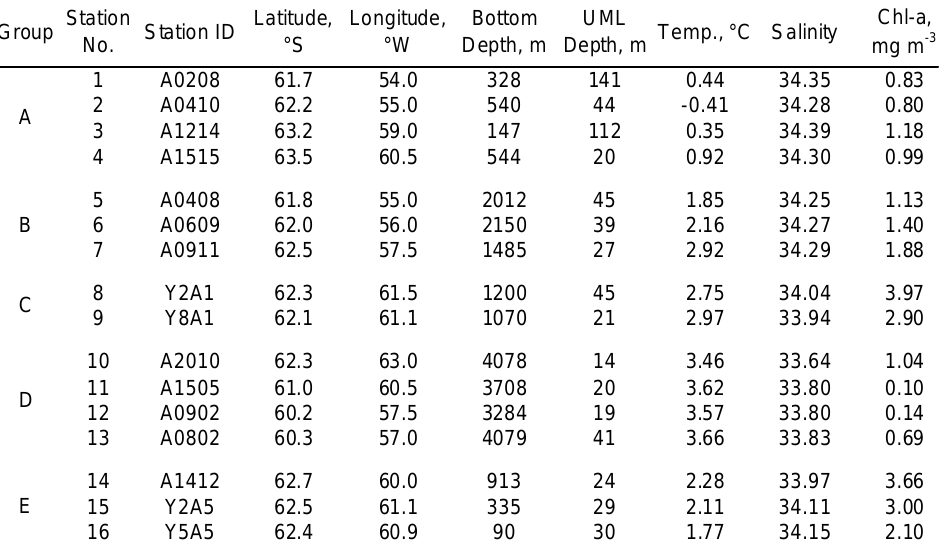
Table 2. Data for the 16 stations shown in Fig. 1b where concentrations of dissolved and total acid leachable Fe were determined. The five groupings of the stations are based on common characteristics, including water depth and proximity to different water masses such as Weddell Sea water and Drake Passage water. Depth of the upper mixed layer (UML) was calculated as the depth at which sigma-theta differed by 0.05kgm − 3 from the mean density between 5 and 10m depth. Values shown for temperature, salinity, and chl- a are mean values in the